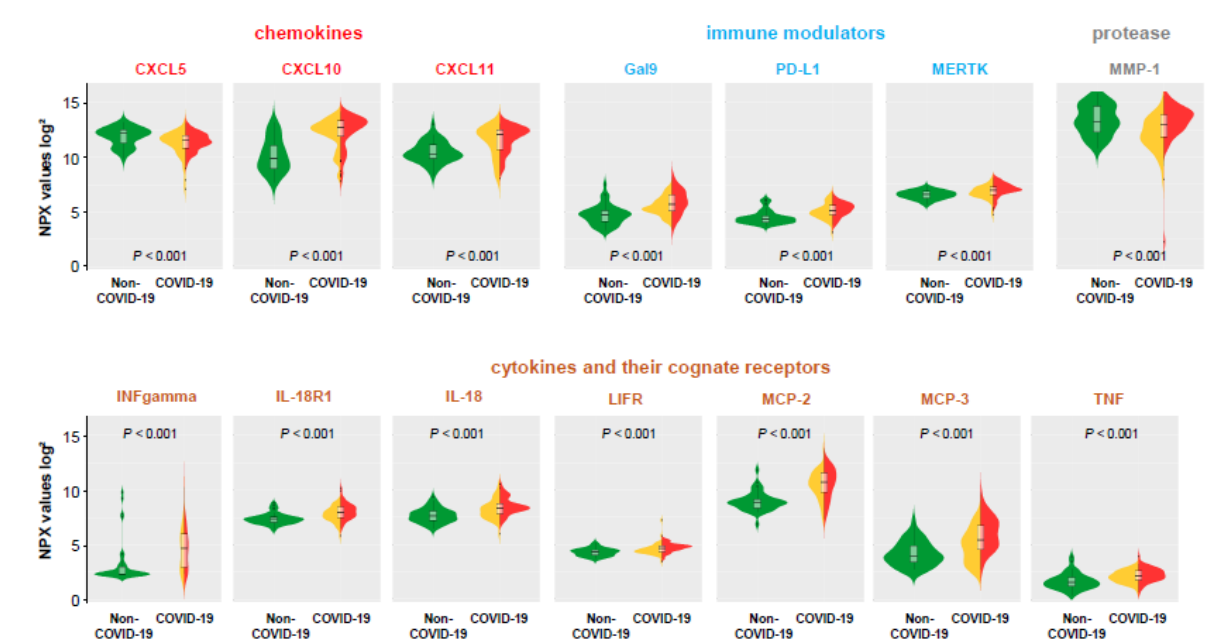
Figure 3. Proteome analyses—PEA values of discriminatory analytes with significant differences ( p < 0.001) between non-COVID-19 and COVID-19 patients. Data are visualized by violin plots, which are a combination of kernel density plots, and box plots depicting median, 25th, and 75th percentiles. A high-normalized protein expression (NPX) value resembles a high protein concentration and expresses the relative quantification between samples. NPX values are given on a log-scale. Green = non-COVID-19; yellow = COVID-19 without hospitalization; red = COVID-19 with hospitalization; black dots: outliers. Table 1. Selected protein levels analyzed by proximity extension assay (PEA), number of valid measurements, interquartile ranges, and significances ( p -values) of the non-COVID-19 and the COVID-19 group at the time of admission to the ED. PEA proteome values are selected on the basis of significant differences either between non-COVID-19 patients and COVID-19 patients, or within the COVID-19 patient group regarding significant predictive impact (refer to Table 2). Only p -values < 0.001 are depicted in bold.